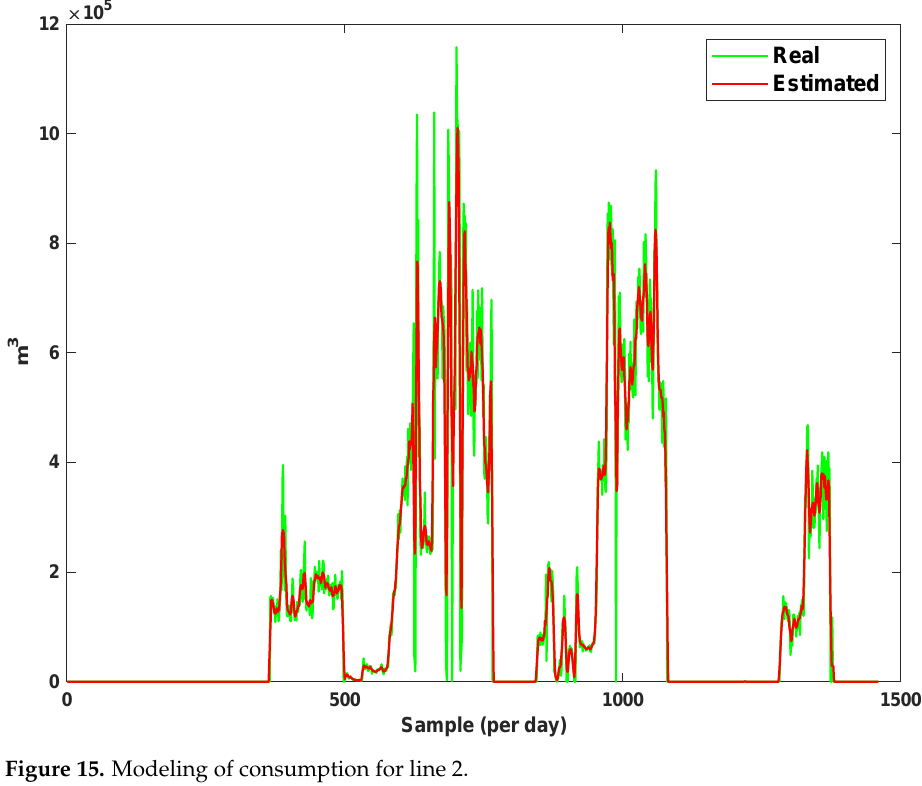
Figure 15. Modeling of consumption for line 2.